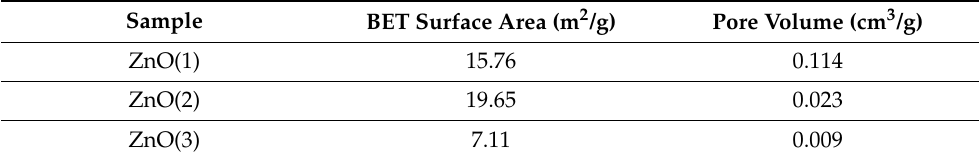
Table 2. BET surface area and pore volume of all